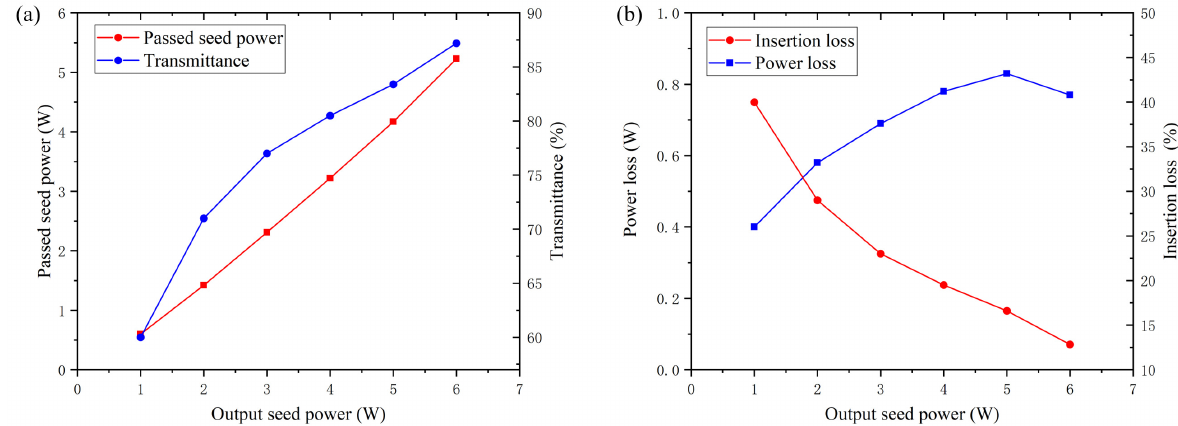
Figure 8. Transient seed power and the transmittance as function of the output seed power ( a ) and power loss and insertion loss as function of the output seed power ( b ).